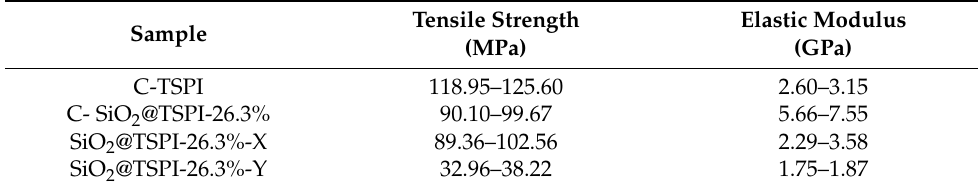
Figure 10. ( a , b ): The mechanical properties of TSPI film, SiO 2 @TSPI film, and printed SiO 2 @TSPI composites. Table 3. Data of mechanical properties .